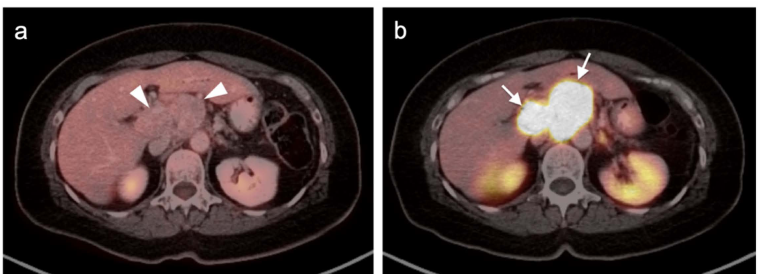
Figure 40. Well-differentiated NET comparison between FDG PET-CT ( a ) and [ 68 Ga-DOTA-TATE PET-CT ( b ). ( a ) Axial FDG PET-CT of the upper abdomen in a patient with a well-differentiated carcinoid tumor metastatic to the caudate lobe of the liver and bulky nodes at the hepatic hilum showing low metabolic activity on FDG PET-CT (white arrowheads). ( b ) An axial [ 68 Ga]-DOTA-TATE PET-CT image for this same patient shows intense activity in the metastatic mass (white arrows). Based on striking uptake of DOTATATE in the metastatic lesions, this patient might be a good candidate for Lutathera ® .